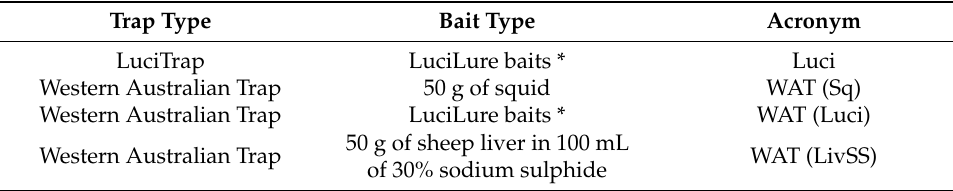
Table 1. Summary of the trap and bait combinations used in this study.